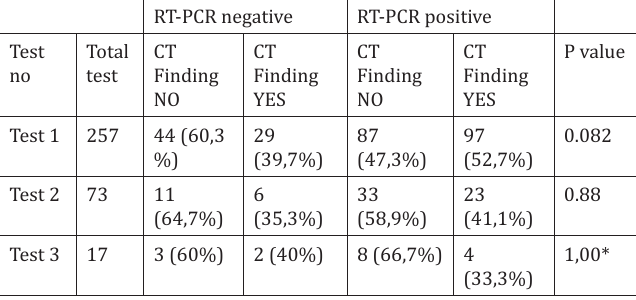
Chi-square test results comparing the CT images with RT-PCR